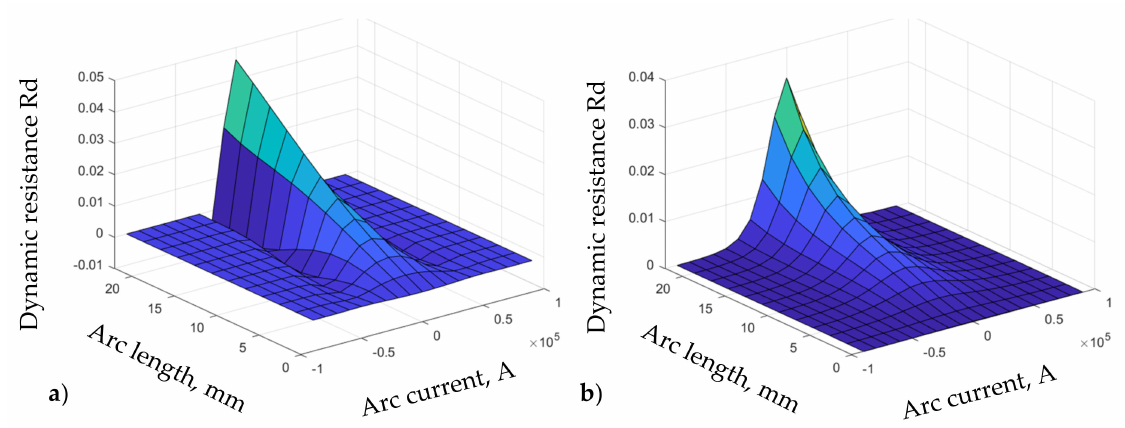
Figure 5. Approximate dependences of dynamic arc resistance changing as a function of current and arc length: ( a ) for current increasing, ( b ) for current